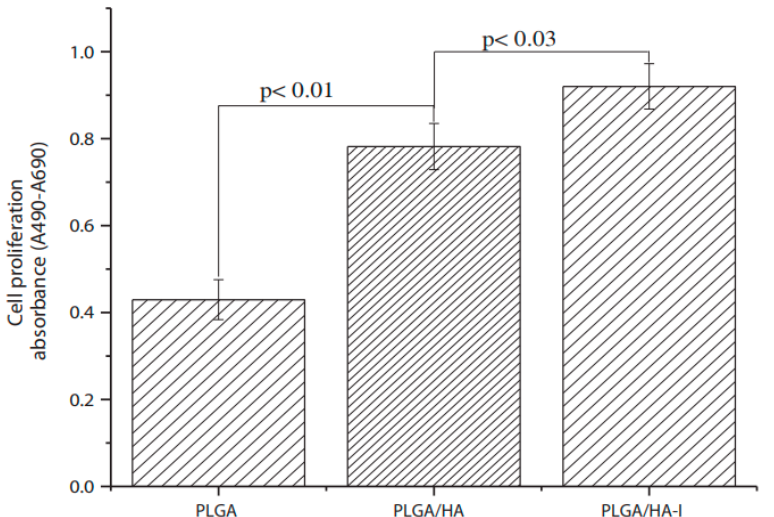
Figure 19. The proliferation of osteoblast cells seeded on pristine PLGA, PLGA/nHA, and PLGA/nHA-I nanofiber scaffolds for two days as determined by a BrdU assay [70].